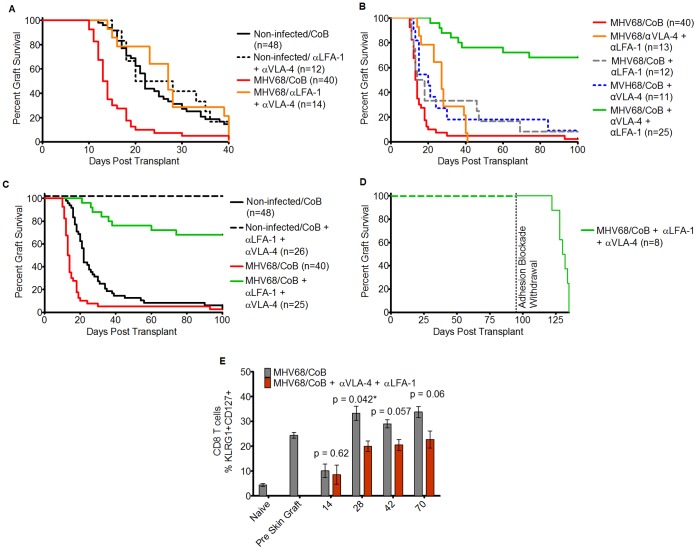
Combined Blockade of costimulation and adhesion pathways overcomes heterologous alloimmunity.A) Kaplan-Meier survival curves comparing skin graft survival between non-infected, CoB treated mice (solid black line, MST 22 d, n = 48, 8 independent experiments), non-infected mice treated with anti-LFA-1 and anti-VLA-4 antibodies (dotted black line, MST 24 d, n = 12, 2 independent experiments), MHV68-infected, CoB treated mice (solid red line, MST 13.5 d, n = 40, 7 independent experiments), and MHV68-infected mice treated with anti-LFA-1 and anti-VLA-4 antibodies (solid orange line, MST 27 d, n = 14, 2 experiments). When non-infected, CoB treated mice were compared to non-infected, anti-LFA-1+ anti-VLA-4 treated mice with the log-rank test, no significant difference was observed (p = n.s.). Comparison of MHV68-infected, anti-LFA-1+ anti-VLA-4 treated mice to non-infected mice treated with either regimen also yielded a non-significant p-value. MHV68-infected, anti-LFA-1+ anti-VLA-4 treated mice demonstrated significantly different skin graft survival compared to MHV68-infected, CoB-treated animals (p = .002). B) Kaplan-Meier survival curves comparing skin graft survival between the following groups: MHV68-infected mice treated with CoB (solid red line, MST 13.5, n = 40, 7 independent experiments); MHV68-infected mice treated with anti-LFA-1/anti-VLA4 (solid orange line, MST 27 d, n = 13, 2 independent experiments); MHV68-infected mice treated with CoB+anti-LFA1 (dotted grey line, MST 16, n = 12, 2 independent experiments); MHV68-infected mice treated with CoB+anti-VLA4 (dotted blue line, MST 20 d, n = 11, 2 independent experiments); MHV68-infected mice treated with CoB+anti-LFA1/anti-VLA4 (solid green line, MST>100 d, n = 25, 3 independent experiments). Statistical comparisons were made with the log-rank test. In infected animals, comparison of combined CoB and dual adhesion blockade to CoB alone yielded p<.0001. Comparison between MHV68-infected animals treated with CoB alone, CoB+anti-LFA-1, and CoB+anti-VLA-4 revealed no significant differences (p = 0.103). C) Kaplan-Meier survival curves comparing skin graft survival between the following groups: Non-infected mice treated with CoB (solid black line, MST 22 d, n = 48, 8 independent experiments); Non-infected mice treated with CoB+anti-LFA-1/anti-VLA-4 (dotted black line, MST>100 d, n = 26, 3 independent experiments); MHV68-infected mice treated with CoB (solid red line, MST 13.5, n = 40, 7 independent experiments); MHV68-infected mice treated with CoB+anti-LFA1/anti-VLA4 (solid green line, MST>100 d, n = 25, 3 independent experiments). Statistical comparisons of skin graft survival between groups were made with the log-rank test. In non-infected animals, comparison of combined CoB+dual adhesion blockade to CoB alone resulted in p<.0001. In MHV68-infected animals, comparison of CoB+anti-LFA-1/anti-VLA-4 treatment to CoB treatment yielded p<.0001. (D) Maintenance adhesion blockade (anti-LFA1/anti-VLA4) therapy was discontinued from 8 MHV68-infected mice (MHV68 WT or MHV68 M1.STOP) treated with CoB+anti-LFA1/anti-VLA4 and who had stable surviving allografts after 90-100 days of treatment with dual adhesion blockade. Following discontinuation of therapy, all grafts failed with a median time of 34 d. (E) Mice treated with combined costimulation and adhesion blockade demonstrated a decreased frequency of KLRG1+/CD127+ CD8+ T cells relative to mice treated with costimulation blockade alone. Gray columns: MHV68-infected mice treated with CoB. Red columns: MHV68-infected mice treated with CoB+antiLFA1/anti-VLA4. Y axis: % of KLRG1+/CD127+ CD8+ T cells expressed as a percentage of total CD8+ T cells. After accounting for multiple testing using the Holm method, this effect was significant at 28 days after skin grafting. In mice treated with CoB alone (n = 6), 33.3% of CD8+ T cells were KLRG1+/CD127+ versus 19.9% in mice with combined treatment (n = 4, p = .042*). Error bars represent the standard error of the mean.